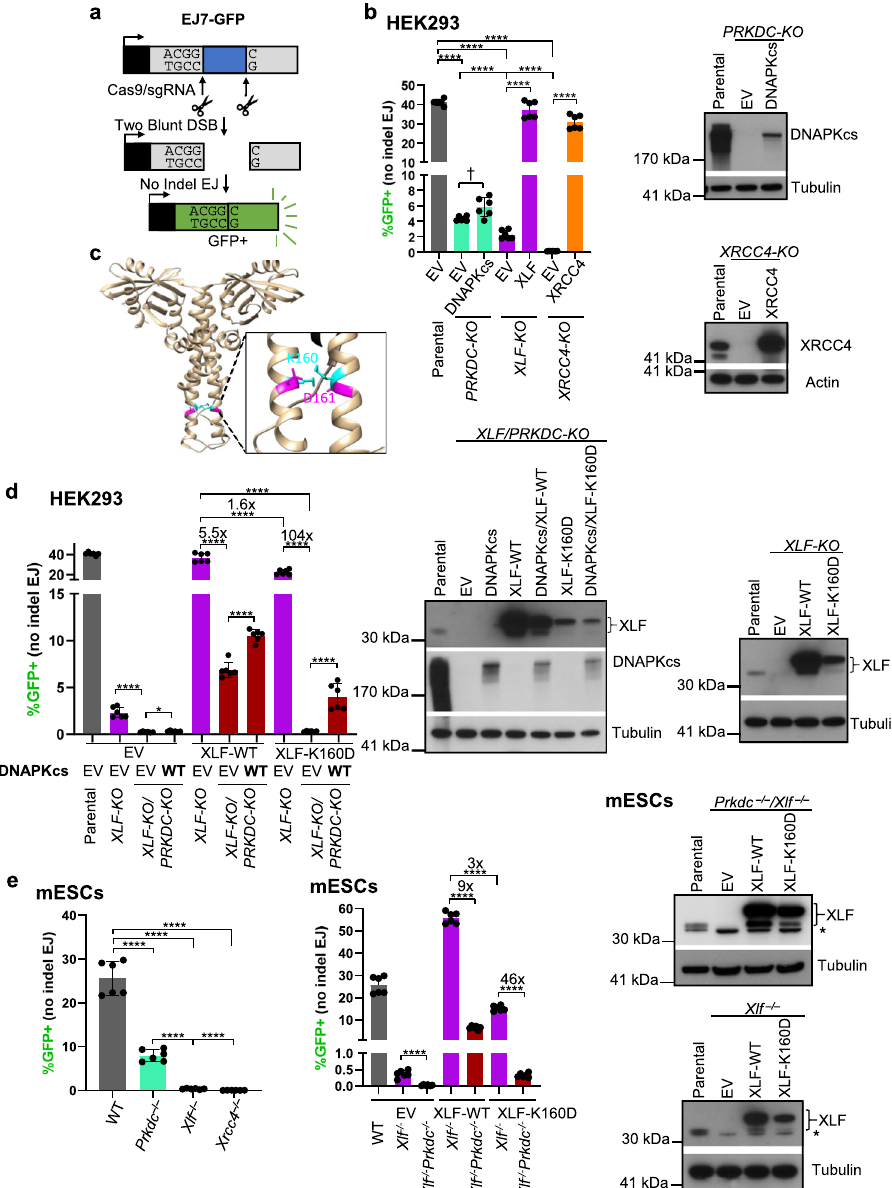
Fig. 1 DNAPKcs is less important for No Indel EJ vs. XLF and XRCC4, but becomes essential in combination with an XLF mutant (K160D). a Shown is the EJ7-GFP reporter for No Indel EJ (not to scale), which is chromosomally integrated using the Flp-FRT system in HEK293 and U2OS cells, and targeting to the Pim1 locus of mESCs. Cells are transfected with expression vectors for Cas9 and the two sgRNAs, with complementing vector(s) or empty vector (EV), and GFP frequencies are normalized to transfection ef fi ciency with parallel GFP transfections. b DNAPKcs is less important for No Indel EJ compared to XLF and XRCC4 in HEK293 cells. n = 6 biologically independent transfections. Statistics with unpaired two-tailed t test using Holm – Sidak correction. **** P < 0.0001, † P = 0.0307 but not signi fi cant after correction (unadjusted P -value). Immunoblots show levels of DNAPKcs and XRCC4. c A reported structure of the XLF homodimer (aa 1 – 227, Protein Data Bank 2R9A), with the K160/D161 salt-bridge highlighted. d DNAPKcs is required for No Indel EJ in HEK293 cells with XLF-K160D. n = 6 biologically independent transfections. Statistics as in ( b ), #x represents fold effect. **** P < 0.0001, * P = 0.0305. Immunoblots show levels of DNAPKcs, XLF-WT, and XLF-K160D. e The in fl uence of DNAPKcs on No Indel EJ is conserved in mESCs. n = 6 biologically independent transfections. Statistics as in ( b ). **** P < 0.0001. Immunoblots show levels of XLF-WT and XLF-K160D. Data are represented as mean values ±